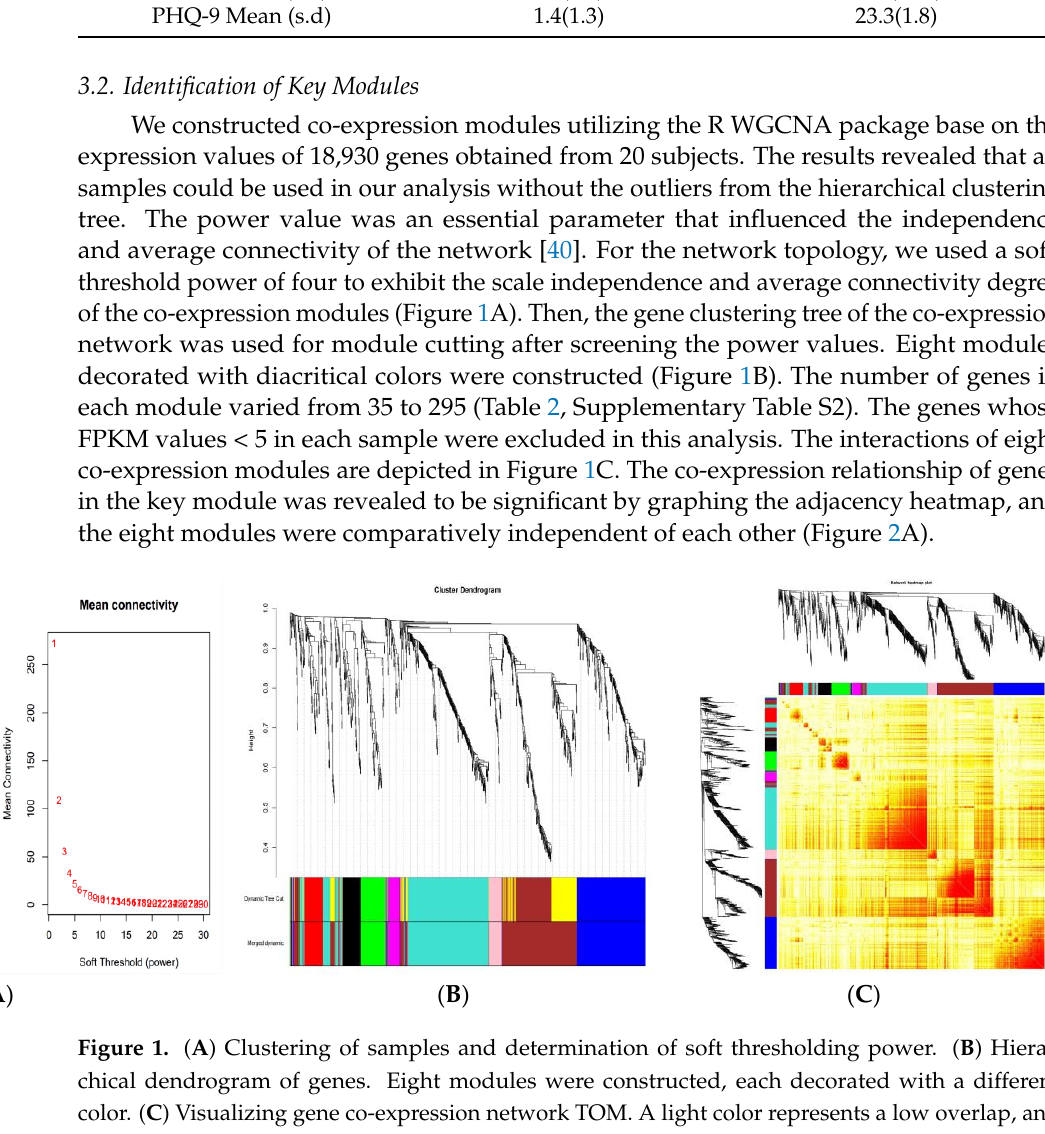
Table 1. Characteristics of MDD and HC adolescents.